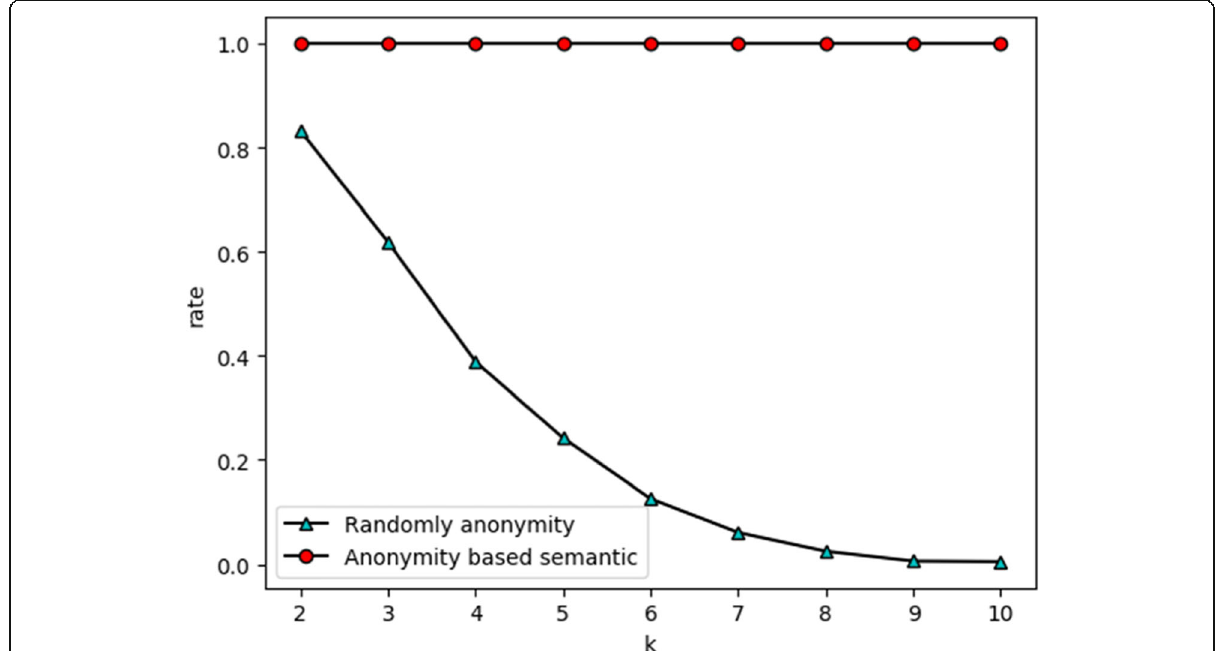
Fig. 12 Anonymous success rate of anonymous method based on location semantics and random dummy location generation. As shown in this figure, red solid circles represent semantic-based anonymity and a blue triangle represents random anonymity. The x - and y -axes represent the size of k and the anonymous success rate, respectively